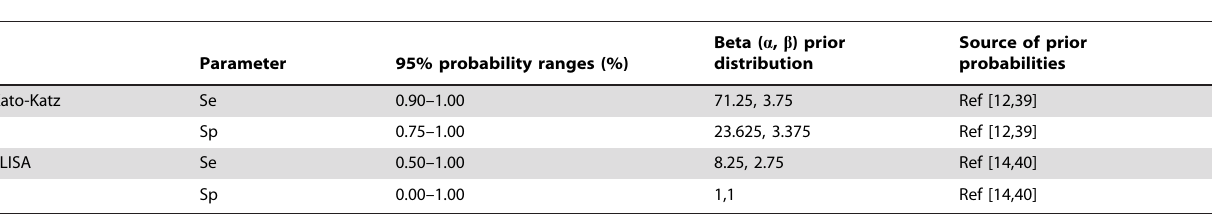
Table 1. Values of priors and corresponding beta distributions used to estimate the test parameters in the diagnosis of Clonorchis sinensis